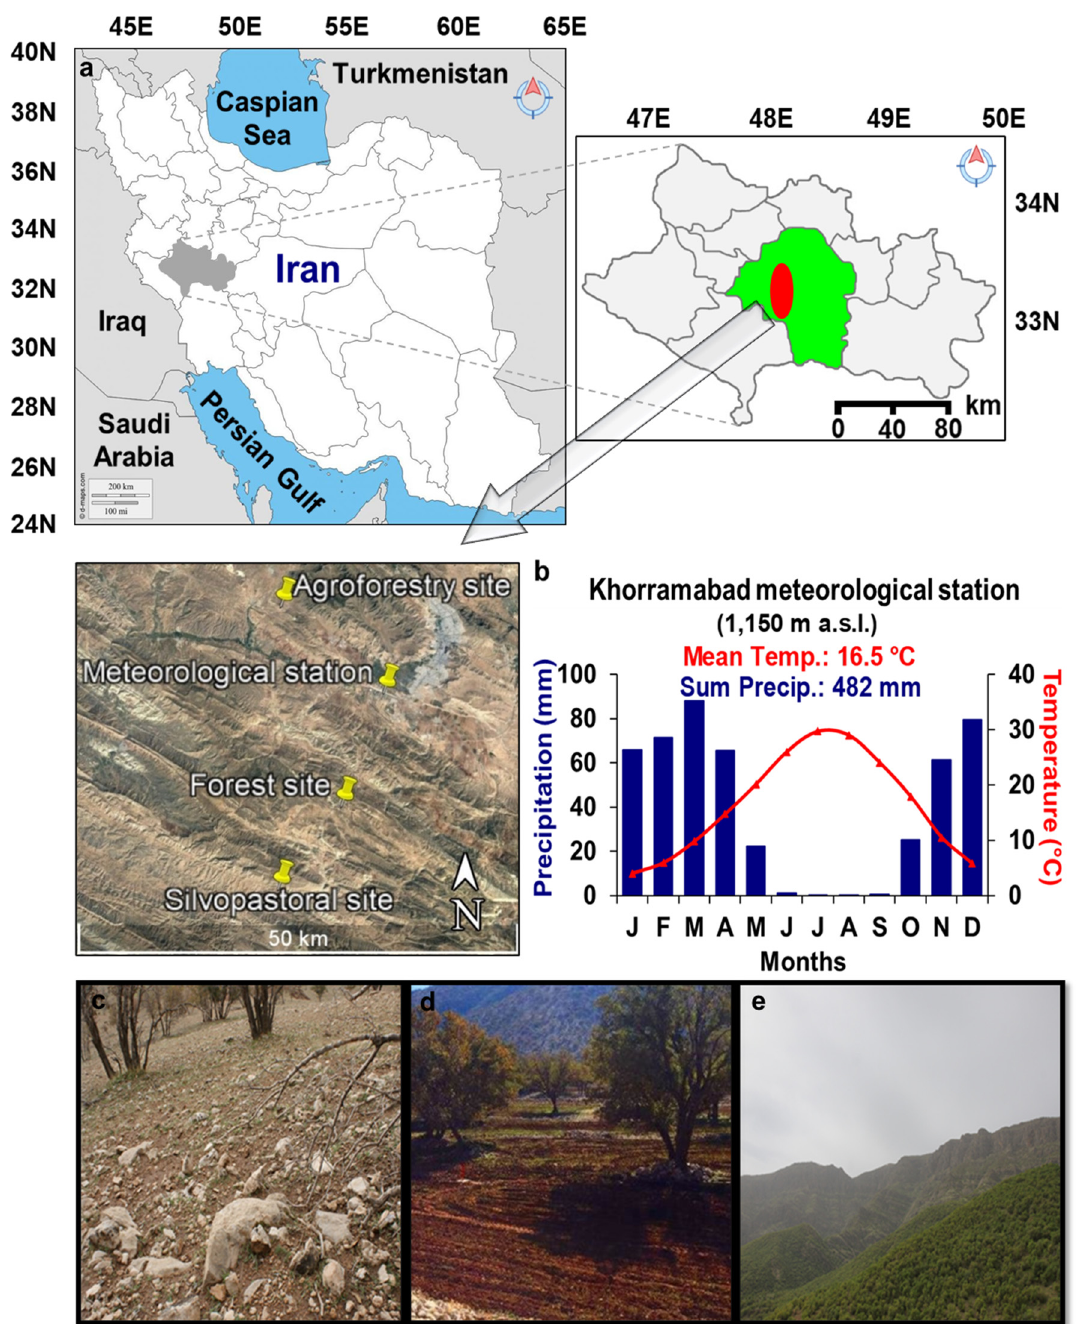
Figure 1. ( a ) Location of the three sampling sites and Khorramabad meteorological station within eht Central Zagros oak forests (red oval), Khorramabad (green area), Lorestan (grey area) in Iran; ( b ) climate diagram that shows average monthly precipitation sums (blue bars) and average monthly temperature means (red line) at Khorramabad meteorological station for the period 1982–2011; ( c ) Shahanshah site with silvopastoral system including intensive livestock grazing; ( d ) Mele- Shabanan site with agroforestry system of rainfed agriculturI ( e ) Dadabad site with forest system and low human intervention.